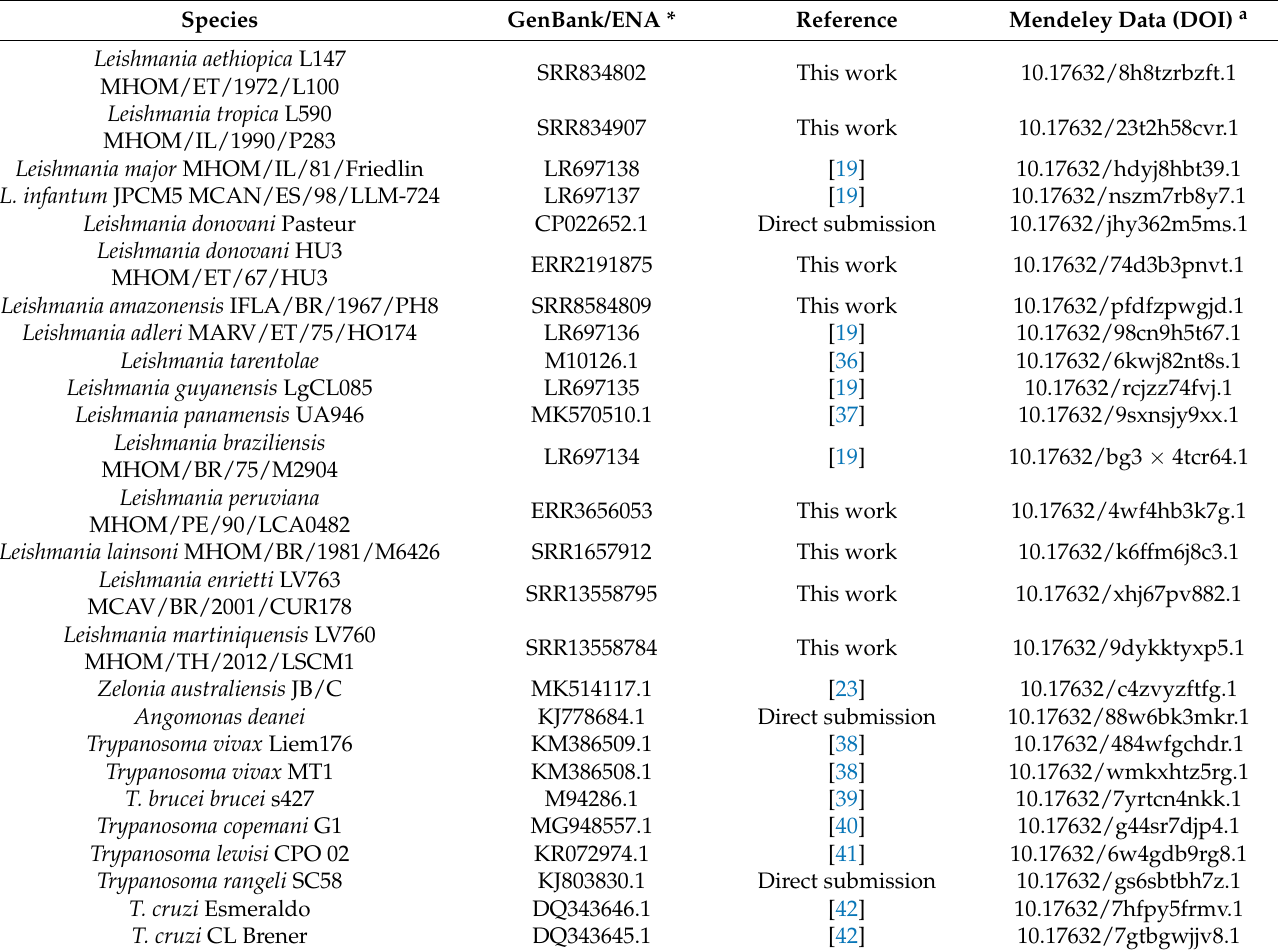
Table 1. Maxicircle sequence datasets from trypanosomatid species used for phylogenetic